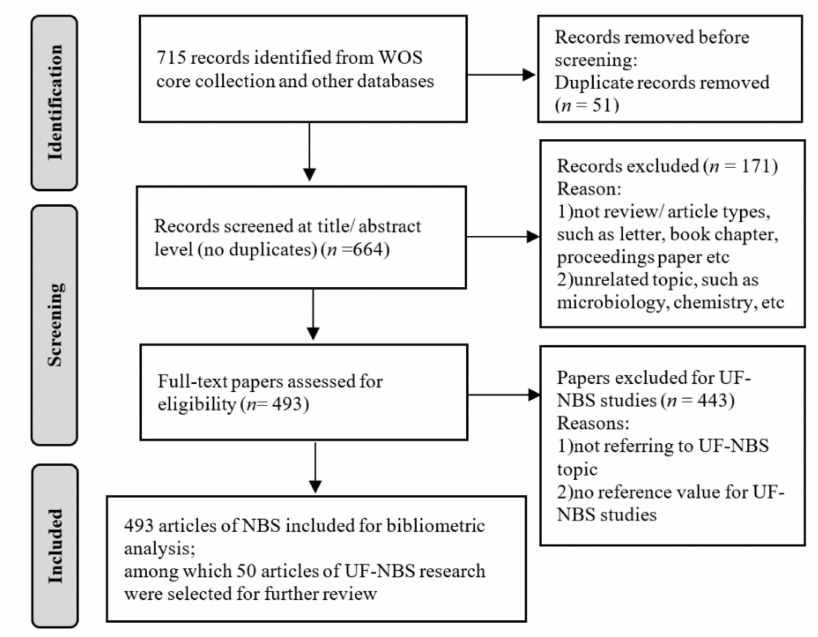
Figure 1. The literature selection process inspired by PRISMA flow